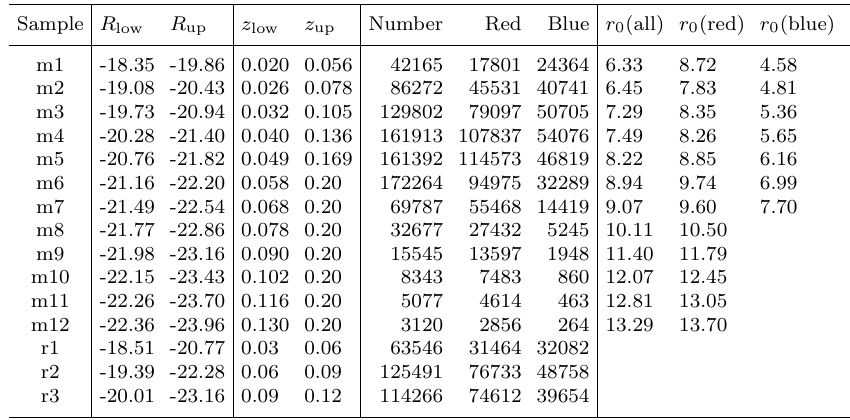
Table 1. Properties of the SDSS volume-limited samples. The correlation length, r 0 , of the different samples is given for samples m1 – m12 (for blue galaxies only m1 – m7). Sample R low R up z